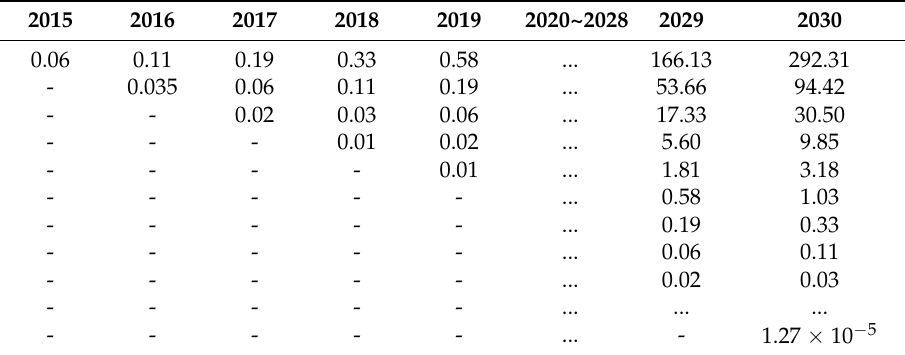
Table 2. Binary tree stochastic process of carbon price (yuan/kwh).